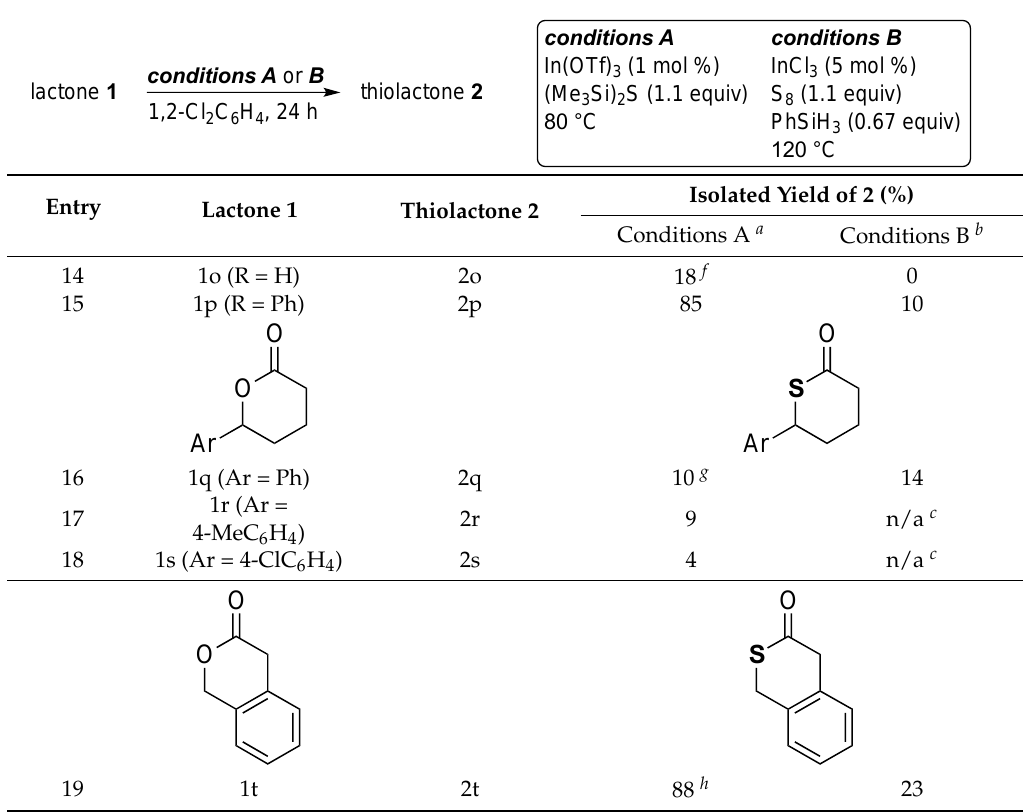
Table 3. Indium-catalyzed conversion of lactones 1 to the thiolactones 2 Table 3. Cont.